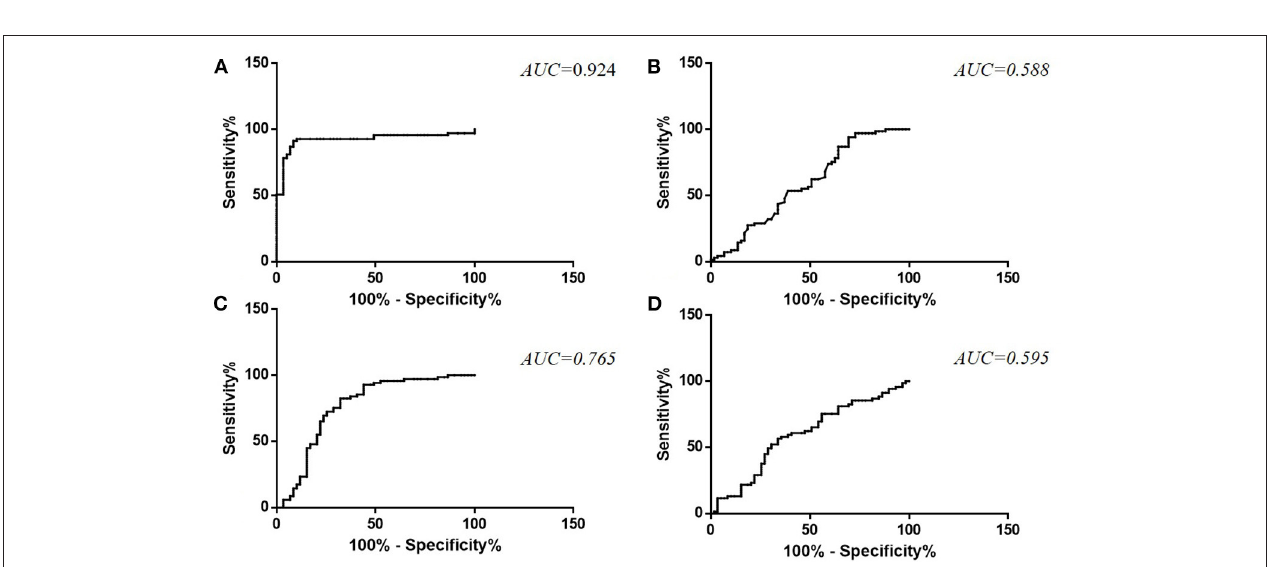
FIGURE 2 | ROC curve for TDP-43 levels in plasma (A) and CSF (B) and pTDP-43 levels in plasma (C) and CSF (D) in ALS patients as compared to healthy controls.